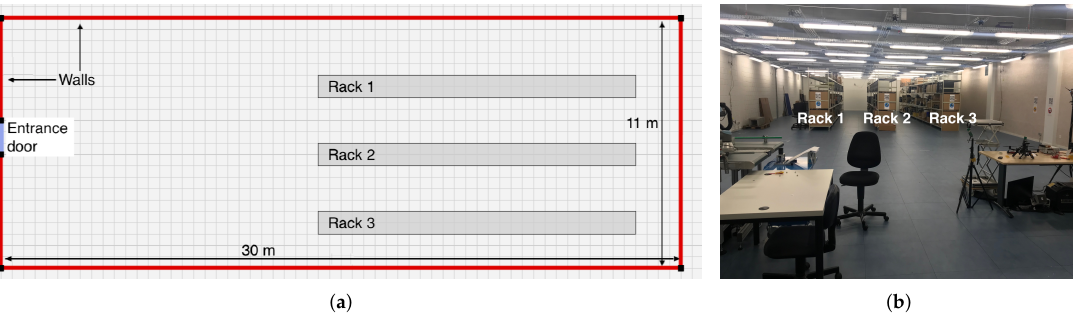
Figure 7. Floor plan and picture of the validation environment (30 m × 11 m). ( a ) Floor plan. ( b )